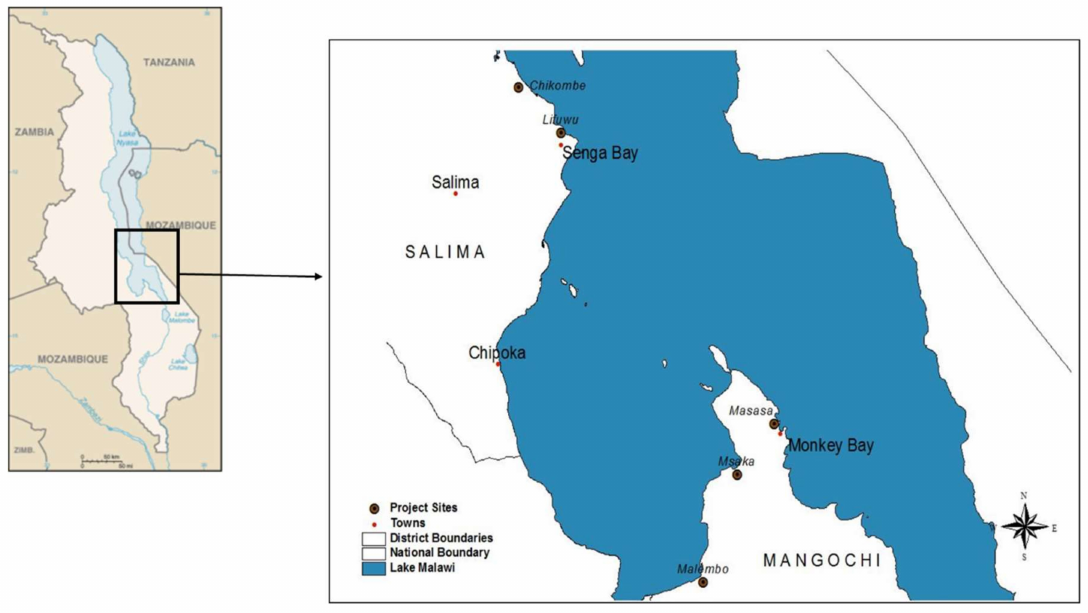
Figure 1. Lake Malawi study